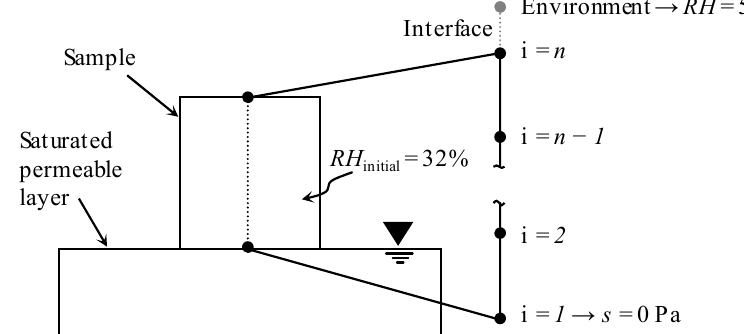
Figure 1. System abstraction discretization, boundary and initial conditions. RH : relative humidity.